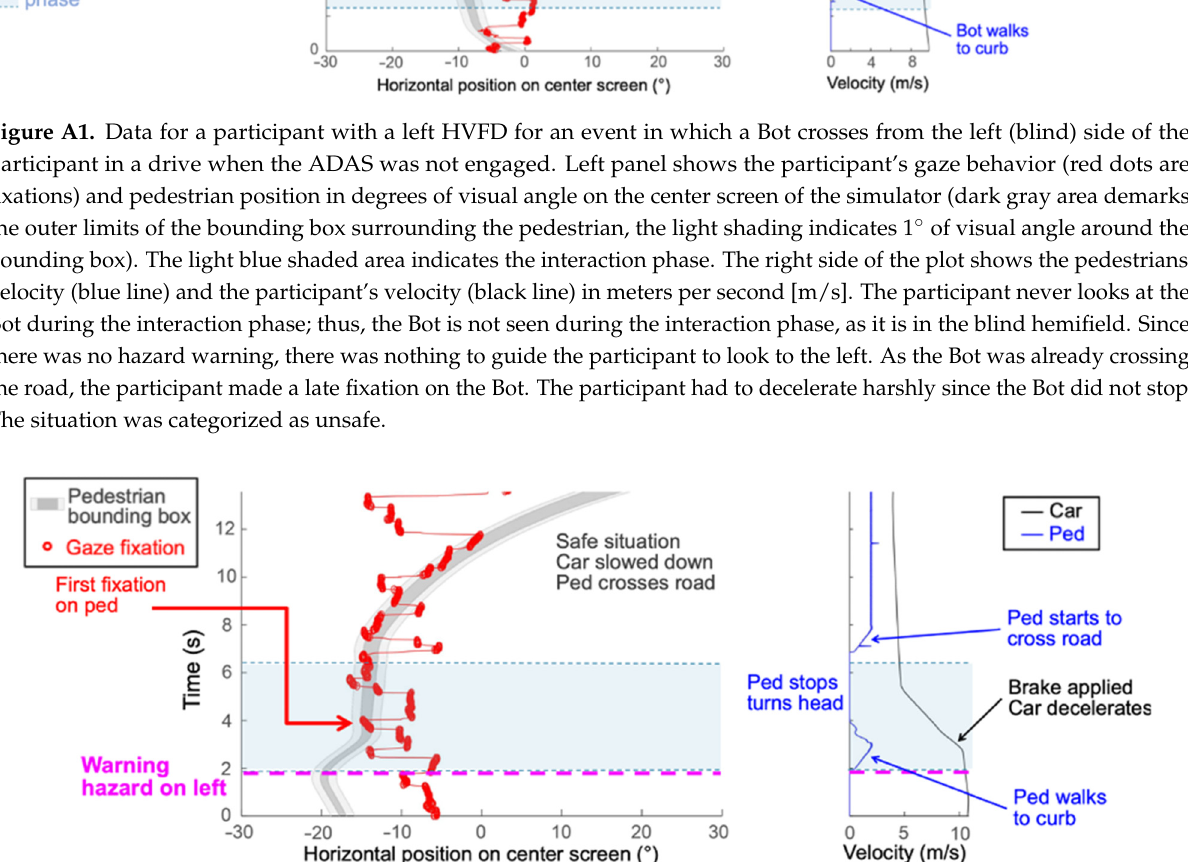
Figure A3. Data for a participant with a left HVFD for an event in which a human-controlled pedestrian (HCped) crosses from the left (blind) side of the participant in a drive when the ADAS was not engaged. For most of the interaction phase, the pedestrian is in the blind hemifield, and the participant did not see the pedestrian make a head turn and indicate the intention to cross. The participant made a late fixation on the HCped, almost at the end of the interaction phase but did not slow down. The human operator thought that it was not safe to cross so the HCped did not cross the road. The situation was categorized as unsafe. References 1.